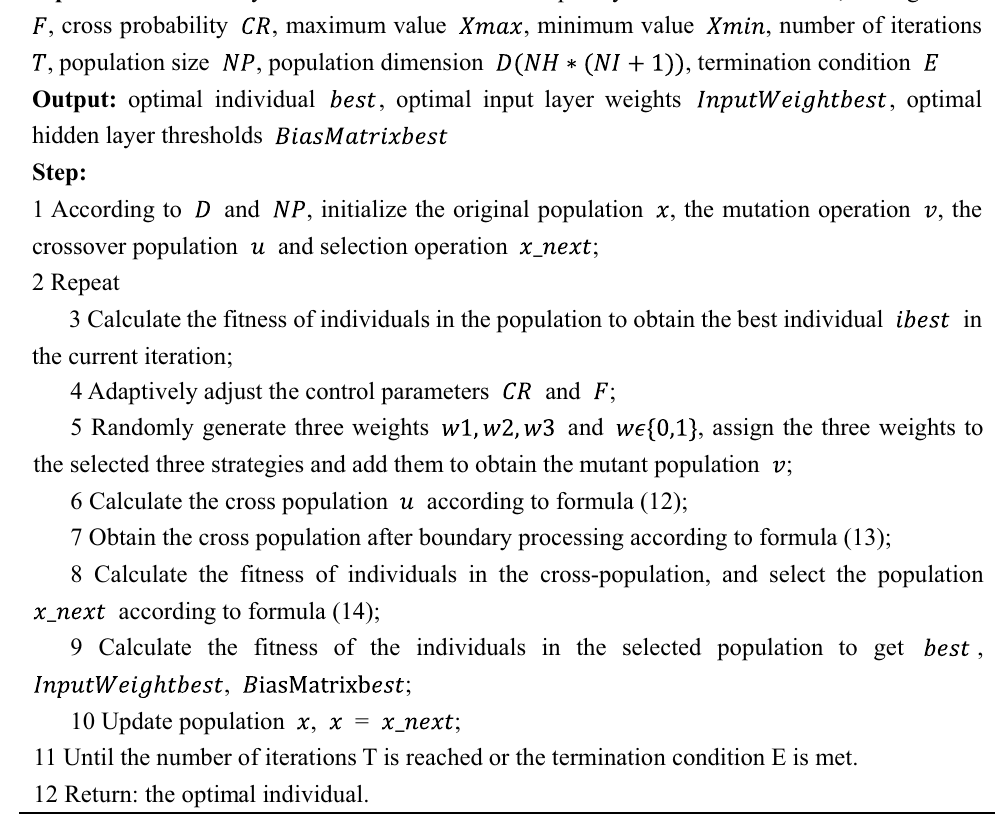
Algorithm 2 M-SDE (Multi-strategy differential